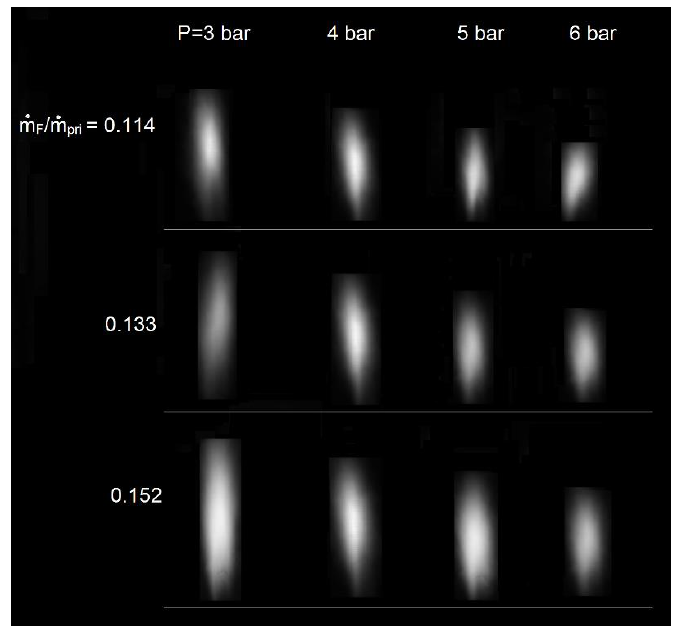
Figure 6. Flame shape for combustor pressure under different ṁ F / ṁ pri ratios.